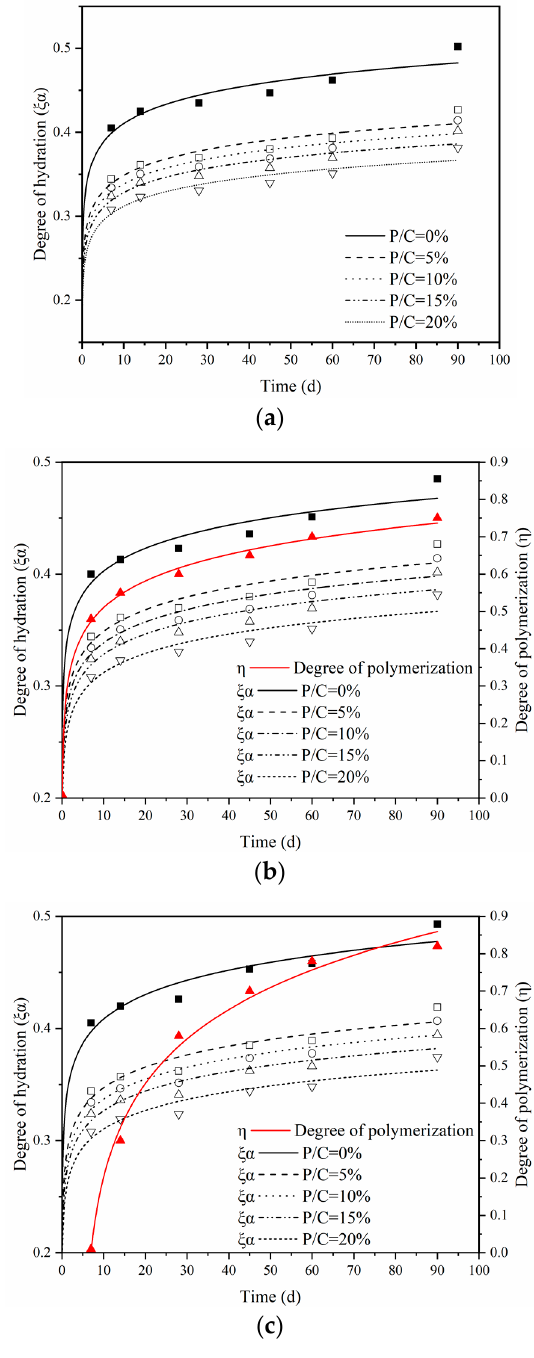
Figure 6. Degrees of hydration and polymerization under different curing regimes: ( a ) dry curing, ( b ) wet curing, and ( c ) wet–dry curing.